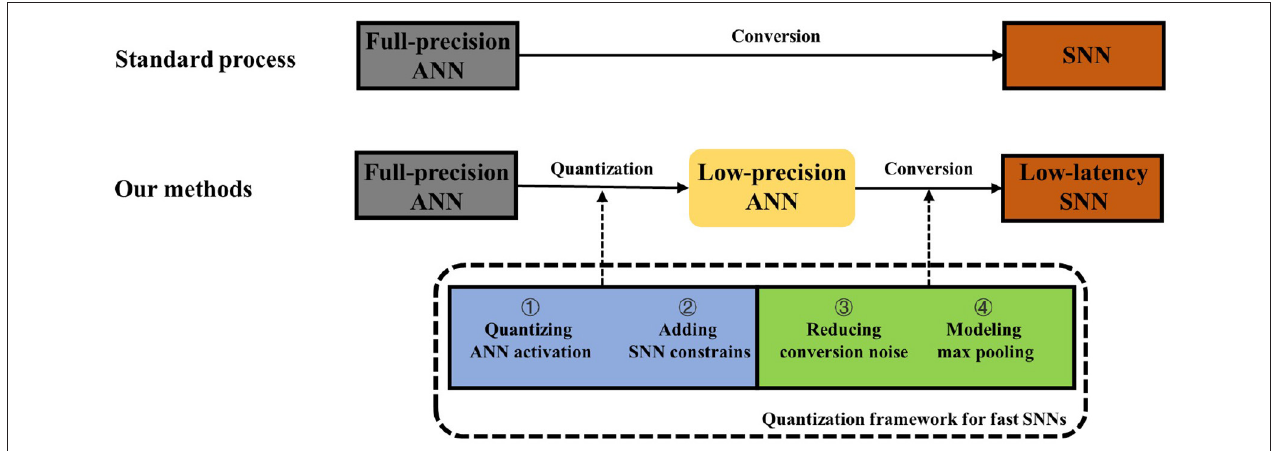
FIGURE 2 | The general ANN-to-SNN conversion diagram and the approach we propose to achieve fast SNNs.